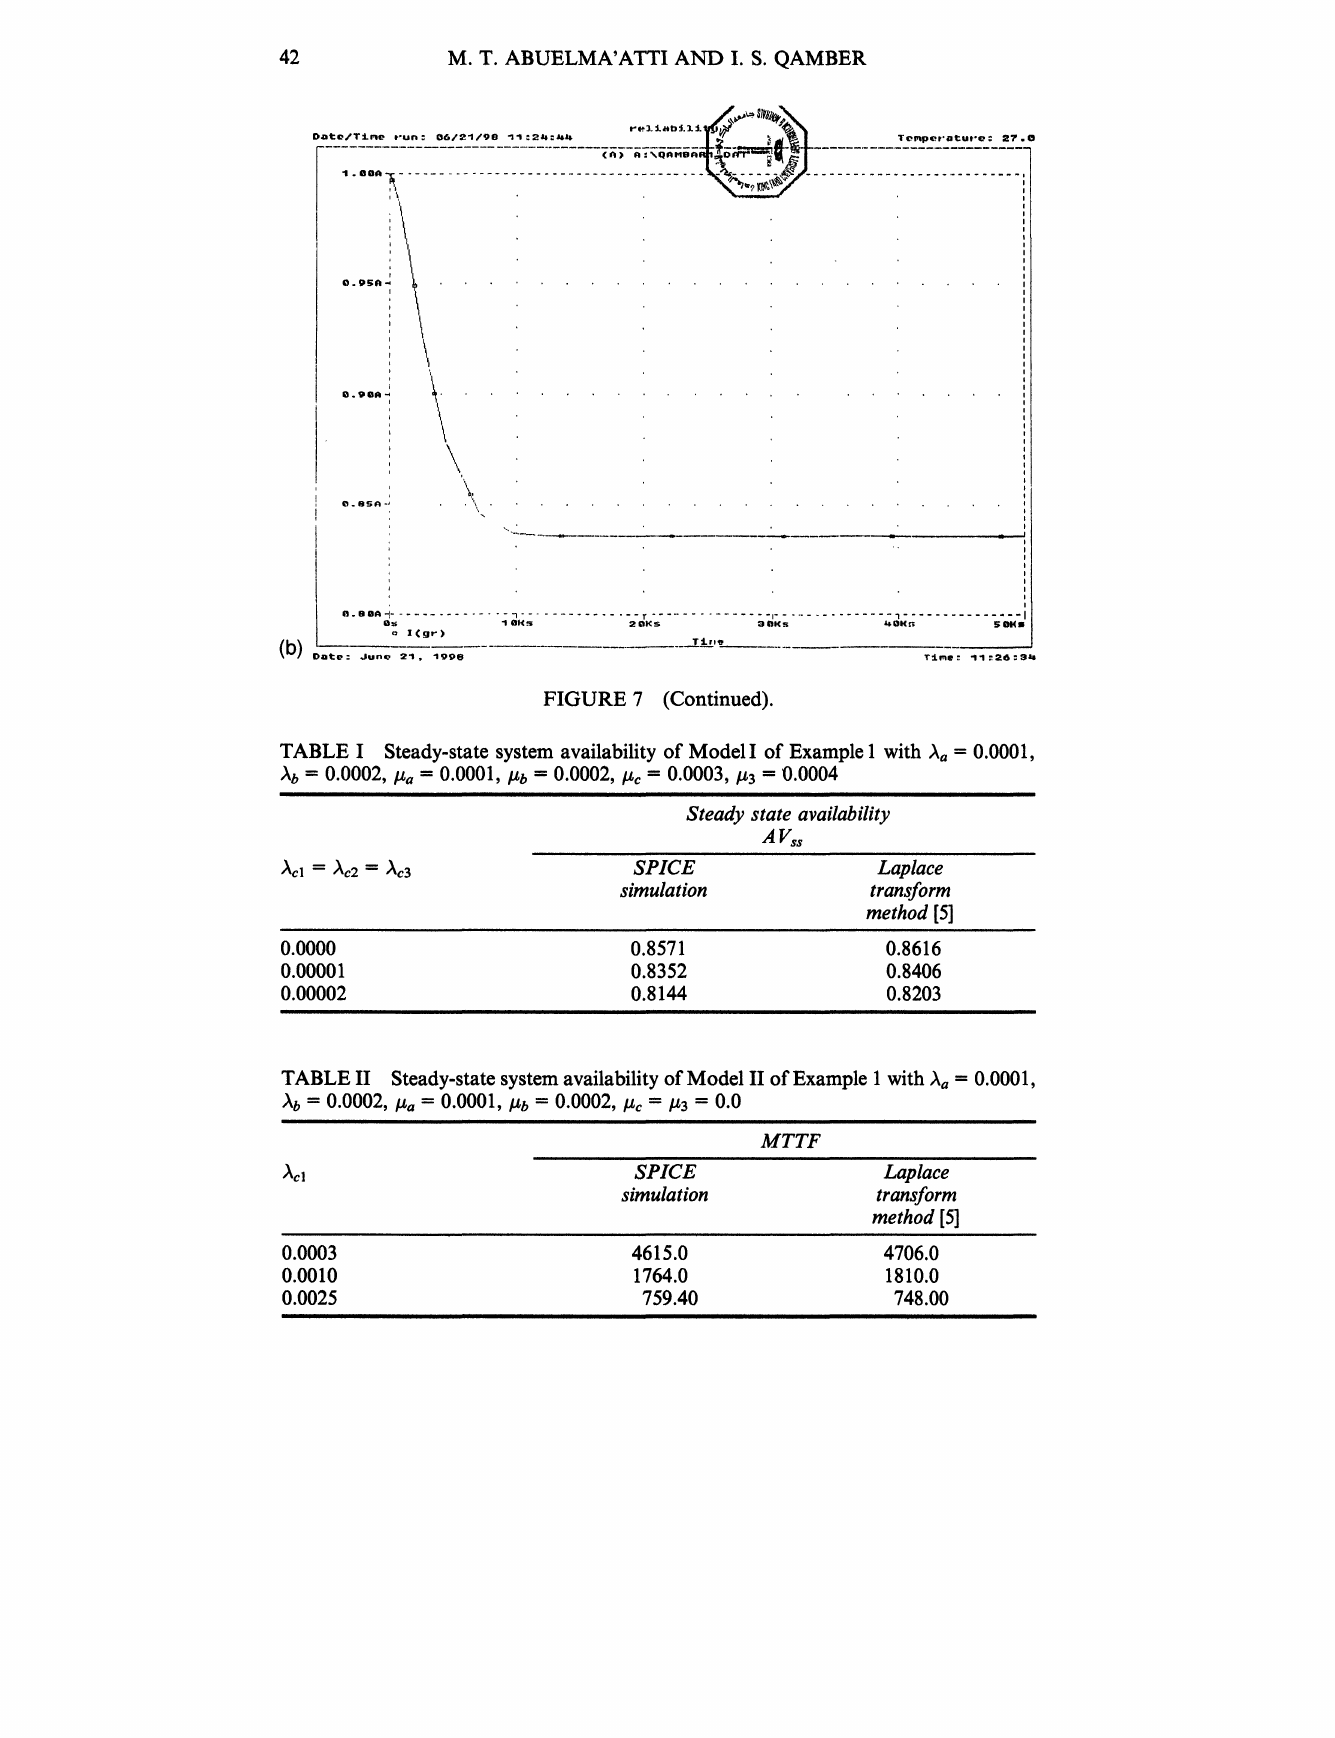
TABLE II Steady-state system availability of Model II ofExample